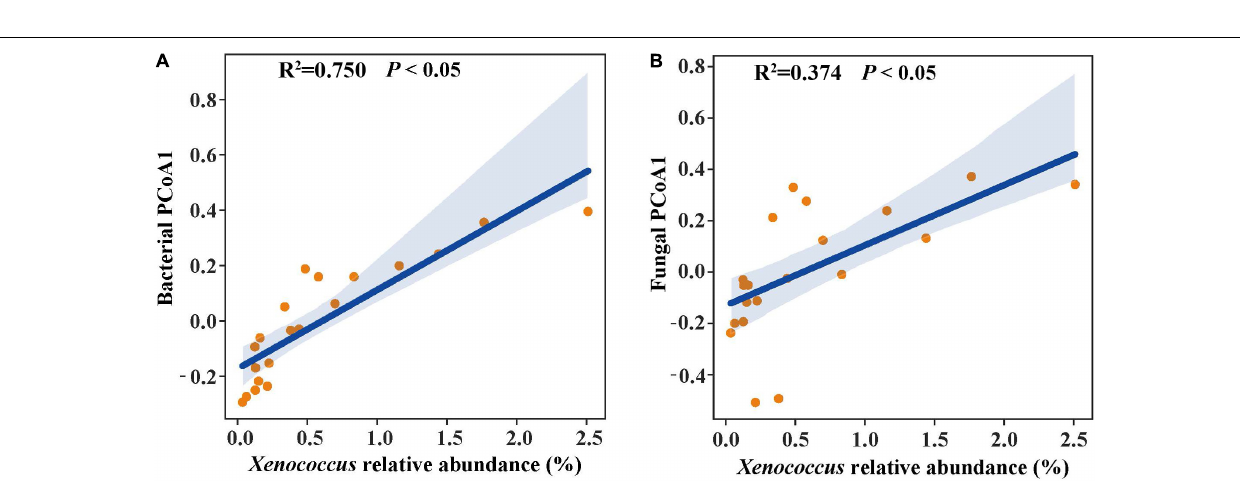
Frontiers in Microbiology |